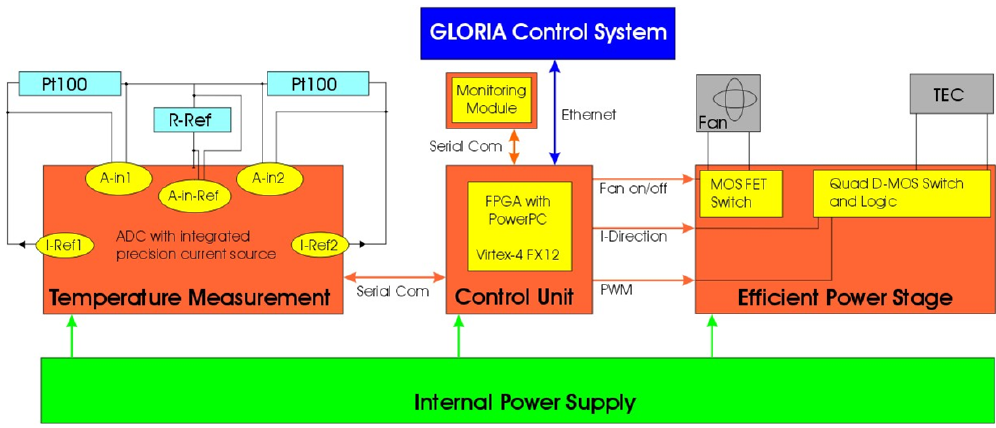
Fig. 10. Schematic of the GBB-electronics: power supply, temperature measurement module, control unit and the efficient power stage for controlling the TECs and the cooling fans.